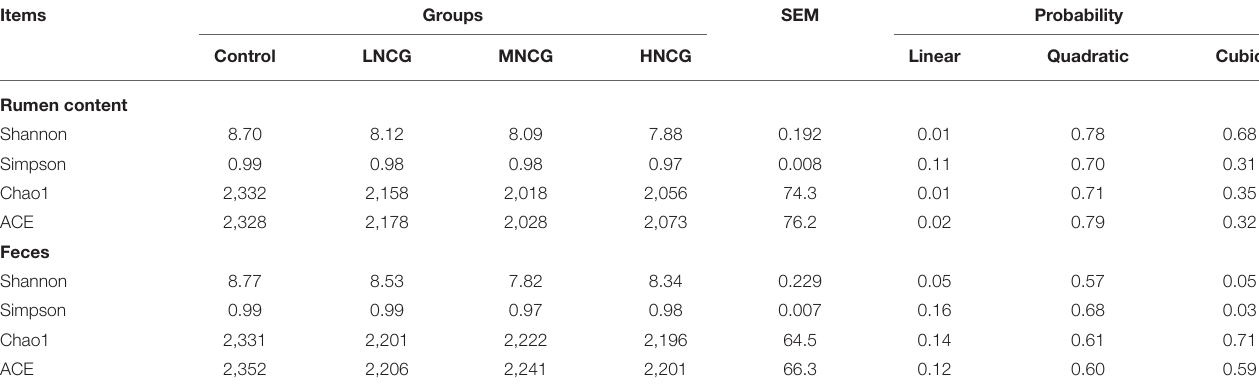
TABLE 2 | Summary of the Alpha diversity of the bacterial community in ruminal and fecal microbiota in different groups. Items Groups SEM Probability